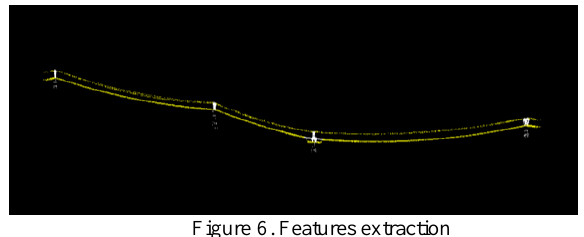
Figure 6. Features extraction